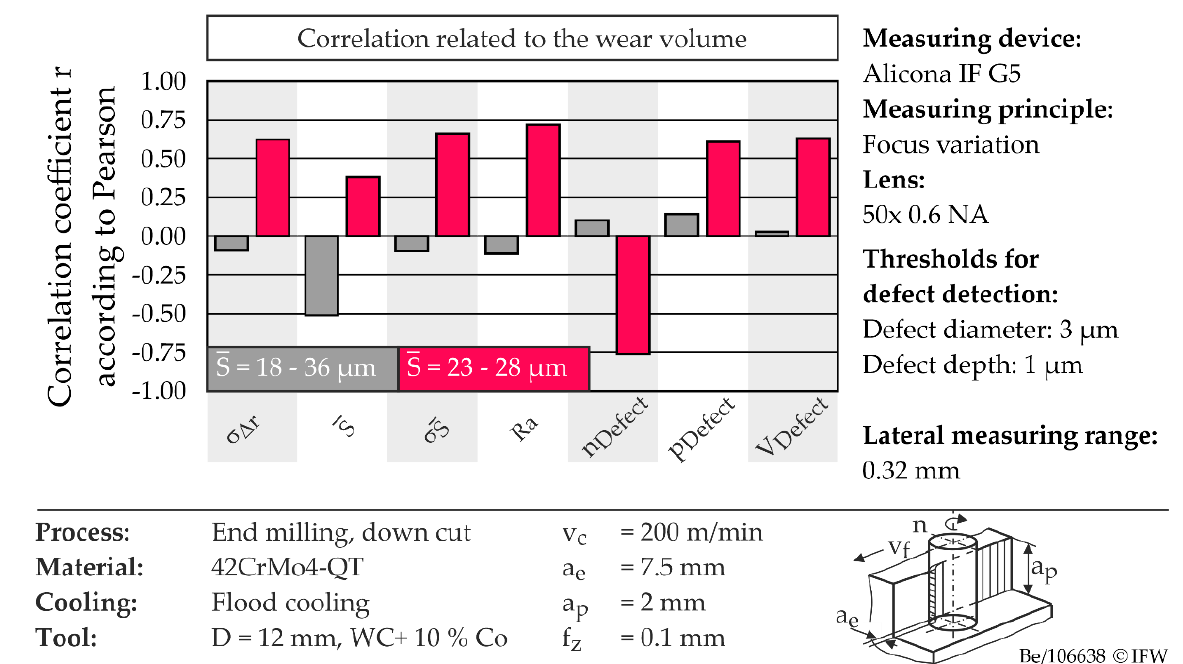
Figure 12. Correlation between the chipping parameters and the wear volume.